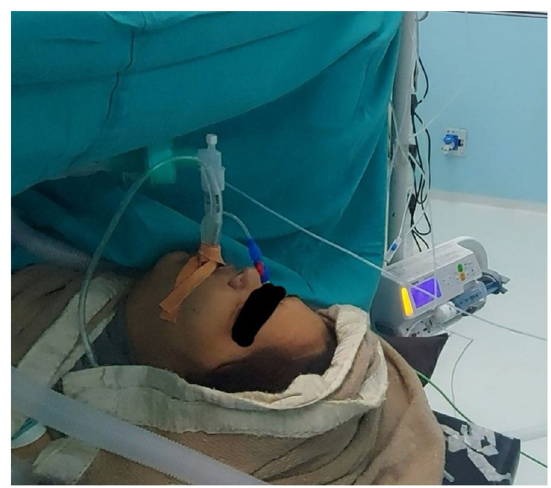
Fig. 2 I-gel supraglottic device used to secure